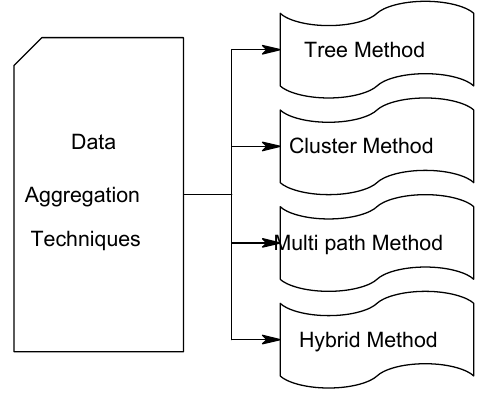
Figure 2. Various data aggregation